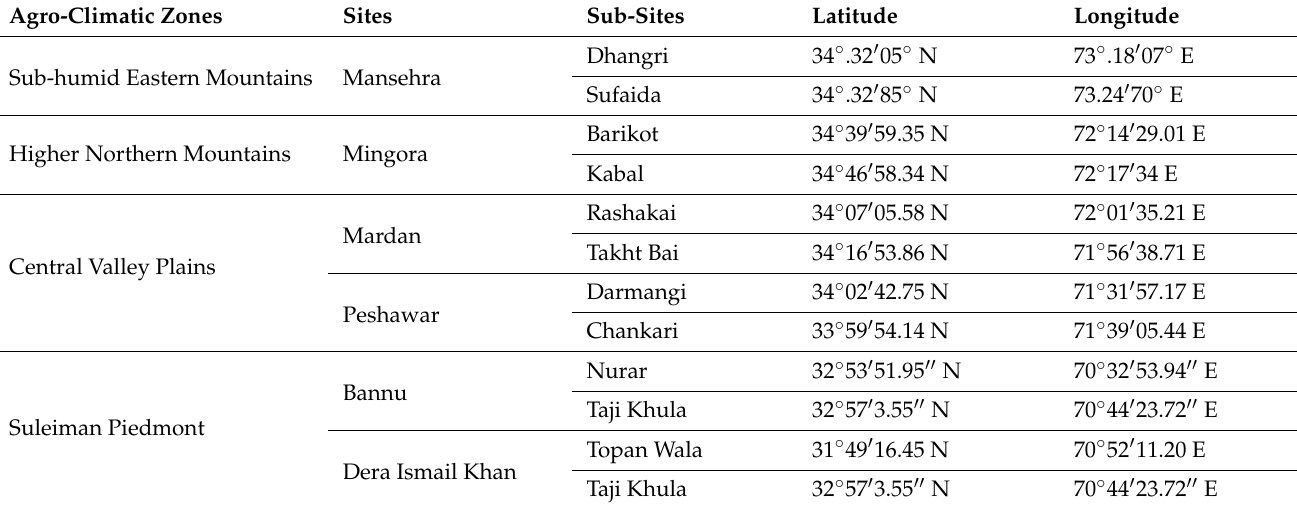
Figure 1. Map depicting the study sites located in Khyber Pakhtunkhwa (KPK), Pakistan. Table 1. GPS locations of study sites for the collection hard ticks during the study period.